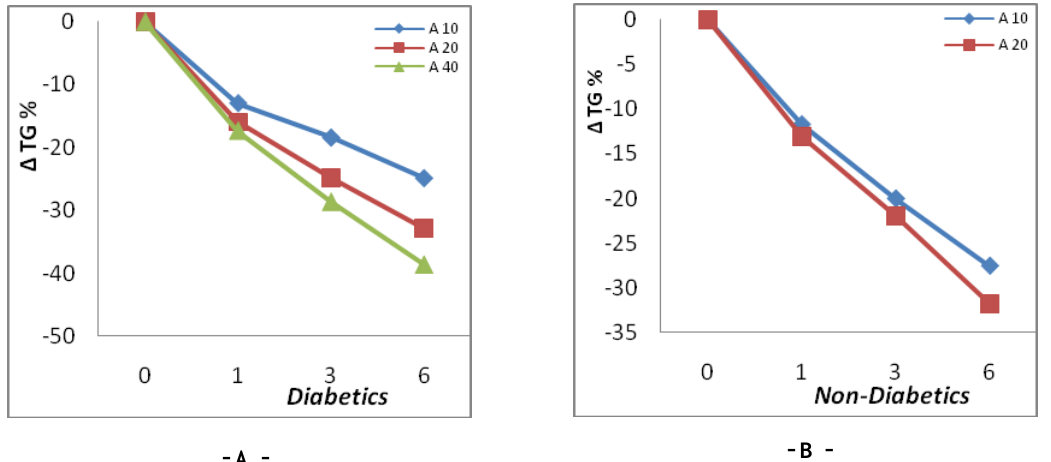
Figure 4 :Line chart showing percentage of serum triglyceride changes after treatment with atorvastatin in diabetics(A) &